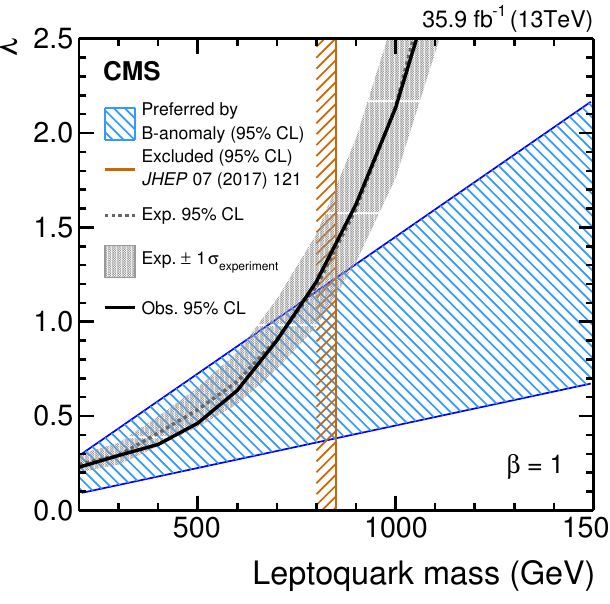
Figure 5 . Expected and observed exclusion limits at 95% con(cid:12)dence level on the Yukawa coupling (cid:21) at the LQ-lepton-quark vertex, as a function of the LQ mass. A unit branching fraction (cid:12) of the LQ to a (cid:28) lepton and a bottom quark is assumed. The orange vertical line indicates the limit obtained from a search for pair-produced LQs decaying to ‘(cid:28) h bb [37]. The left-hand side of the dotted (solid) line shows the expected (observed) exclusion region for the present analysis. The gray band shows (cid:6) 1 standard deviations of the expected exclusion limit. The region with diagonal blue shading shows the parameter space preferred by one of the models proposed to explain anomalies observed in B physics